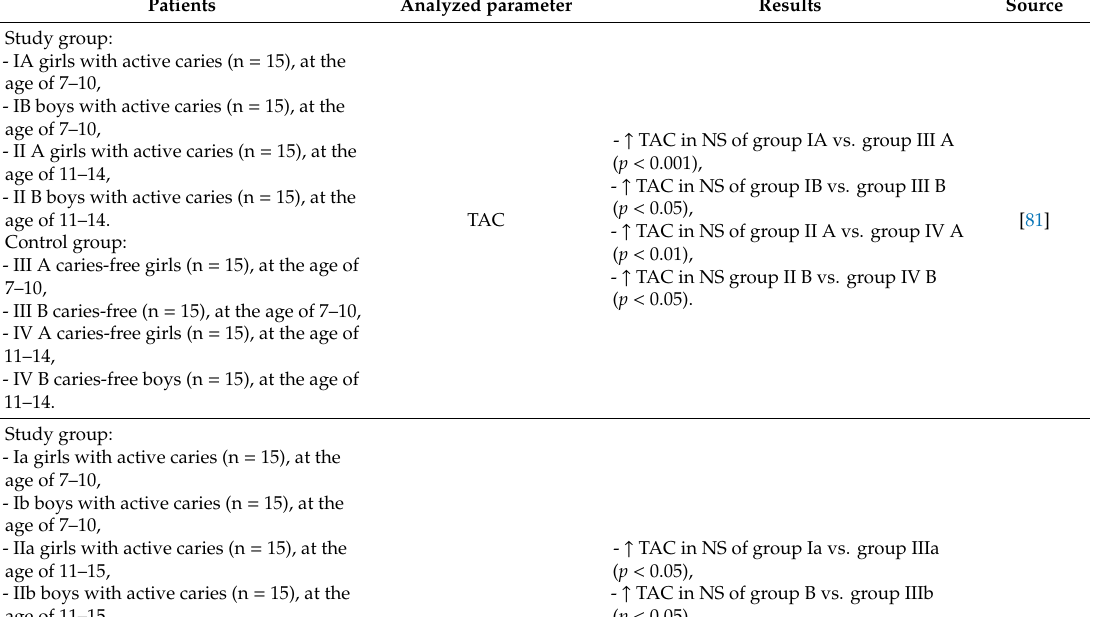
Patients Analyzed parameter Results